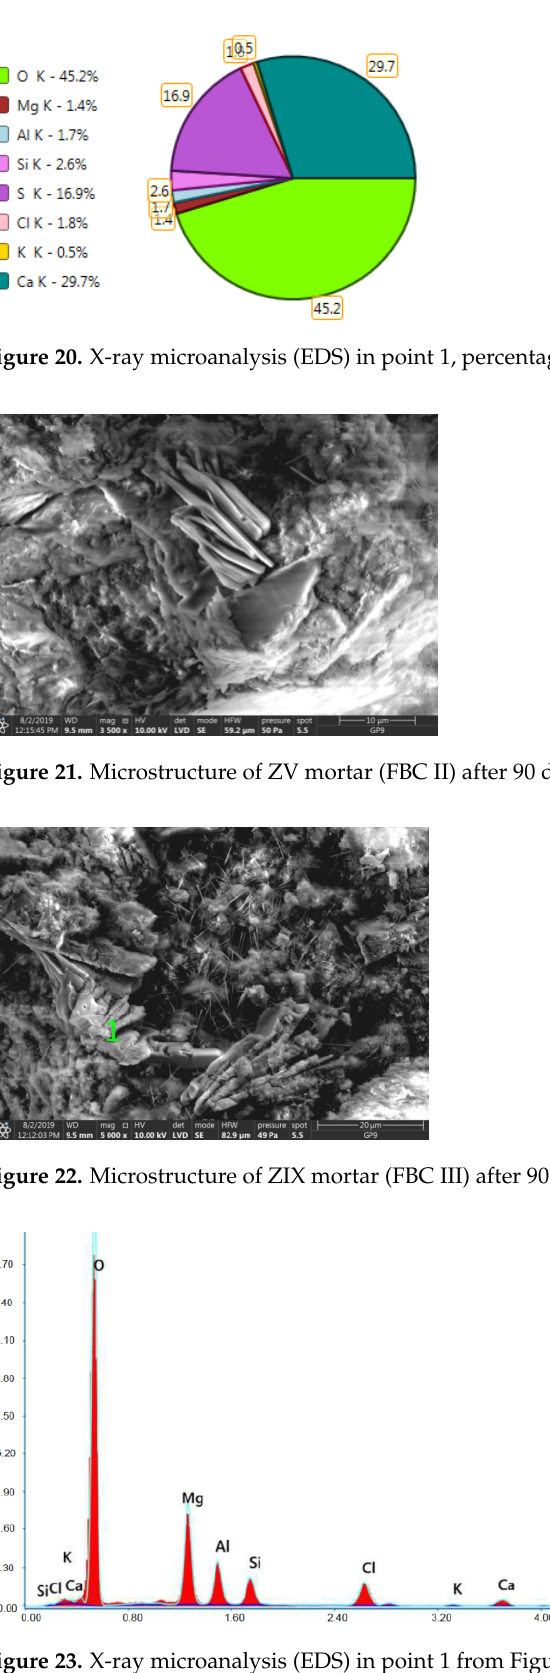
Figure 23. X-ray microanalysis (EDS) in point 1 from Figure 22.